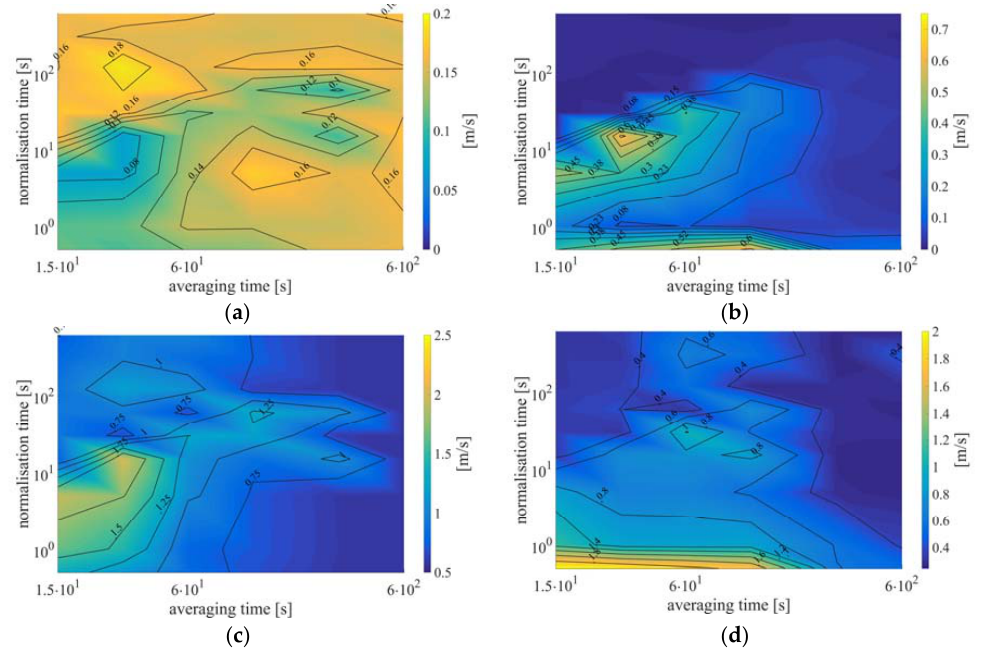
Figure A2. Visualisation of the influence of the normalisation time ∆ t and the averaging time ∆ T on the resulting error of staring mode LiDAR data from 04.01.2014 7:30h (UTC) till 05.01.2014 7:30h (UTC) from the histogram-based dynamic data filter ( a ) Average velocity error, ( b ) average velocity standard deviation error, ( c ) RMS velocity error and ( d ) RMS velocity standard deviation error.